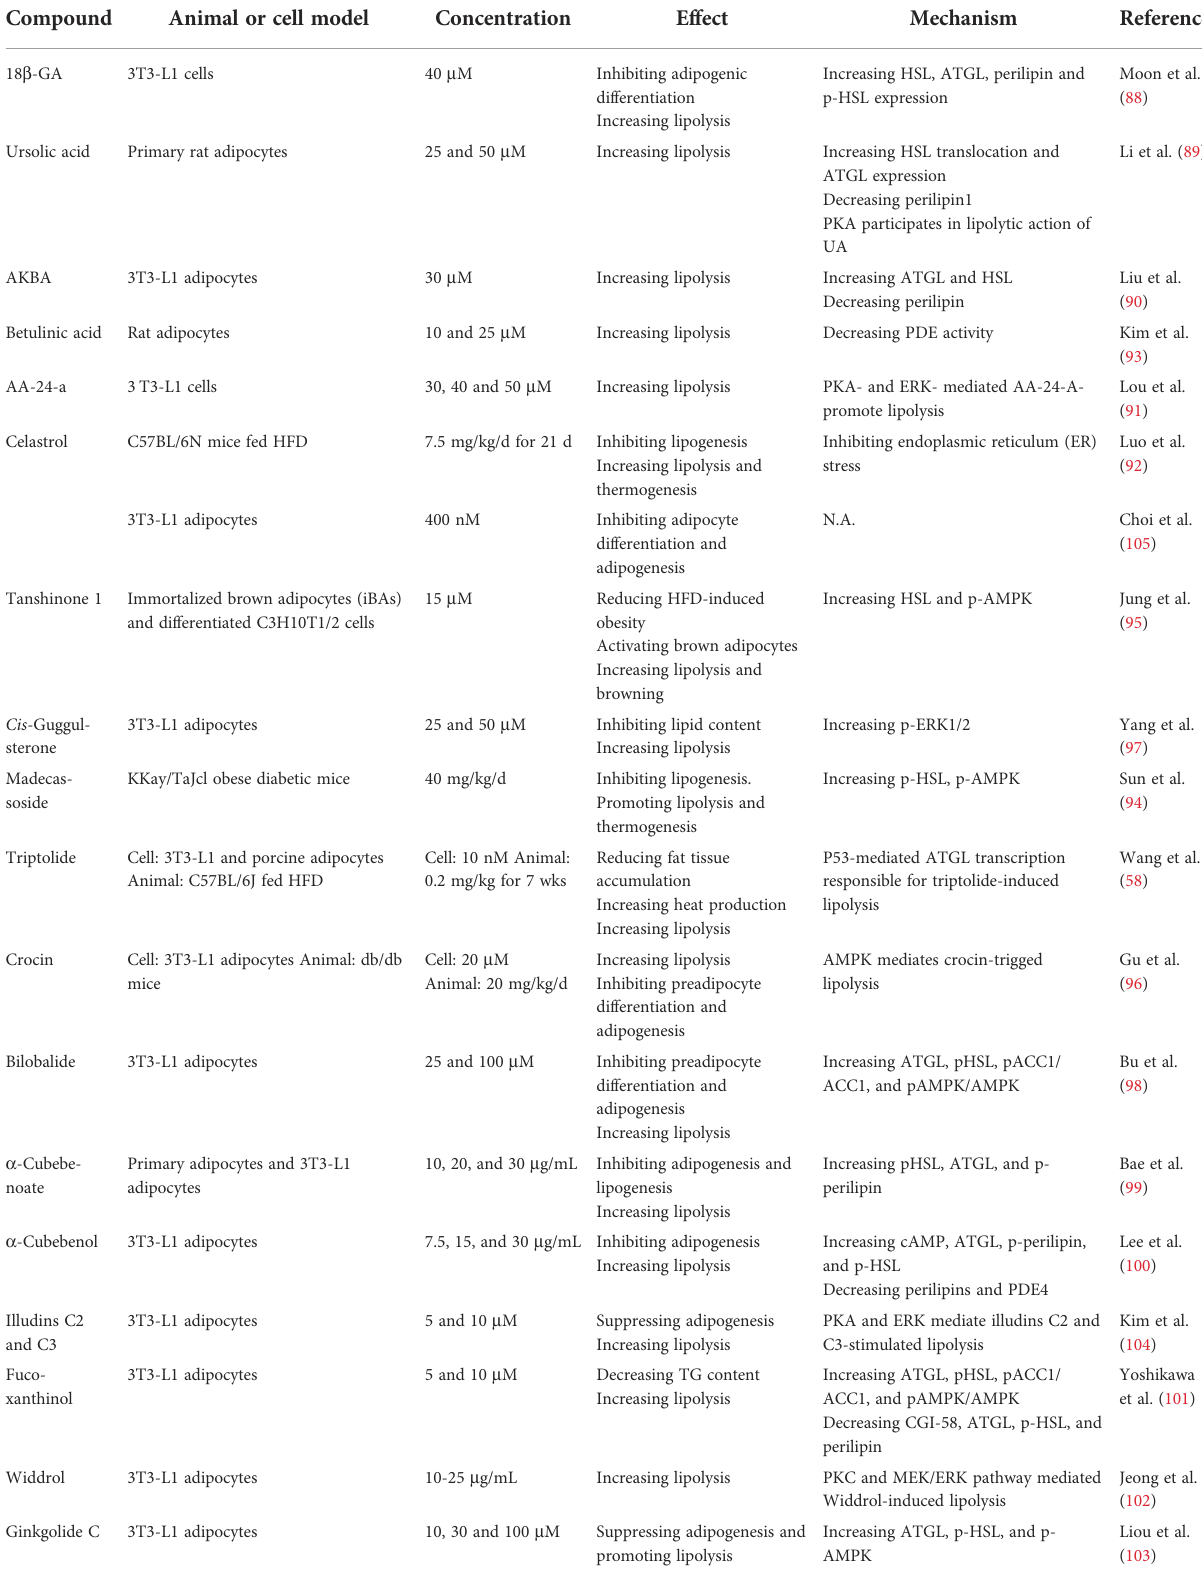
TABLE 3 Lipolytic effects and modes of action of